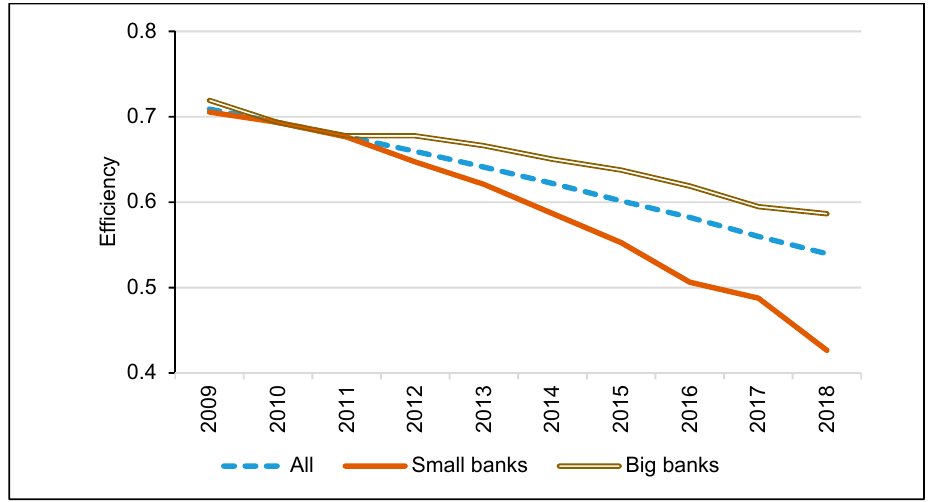
Figure 3. Bank size–mean efficiency. Source: Author’s calculation.